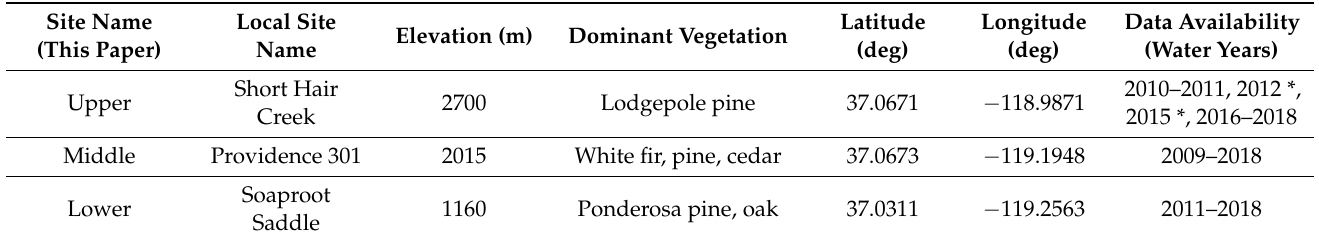
Table 1. Site characteristics of eddy covariance flux towers providing ET observations for this study [28]. These sites are mapped in Figure 1. Water years of data used for this study are listed at right. Years with partial data availability, indicated with asterisk, provided less than 11 out of 12 months’ worth of